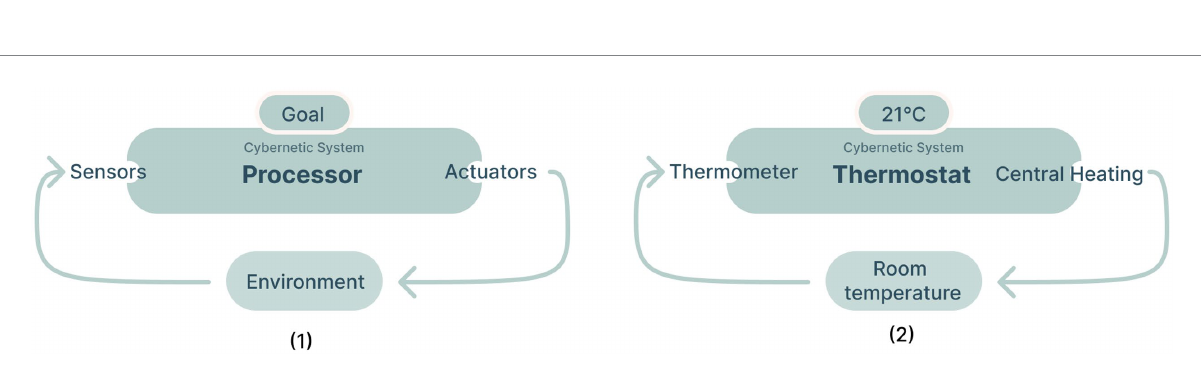
FIGURE 2 The schematic on the left (1) is an abstraction of a typical cybernetic system (adapted from Dubberly and Pangaro, 2007). The schematic on the right (2) shows a typical example of a cybernetic system, a